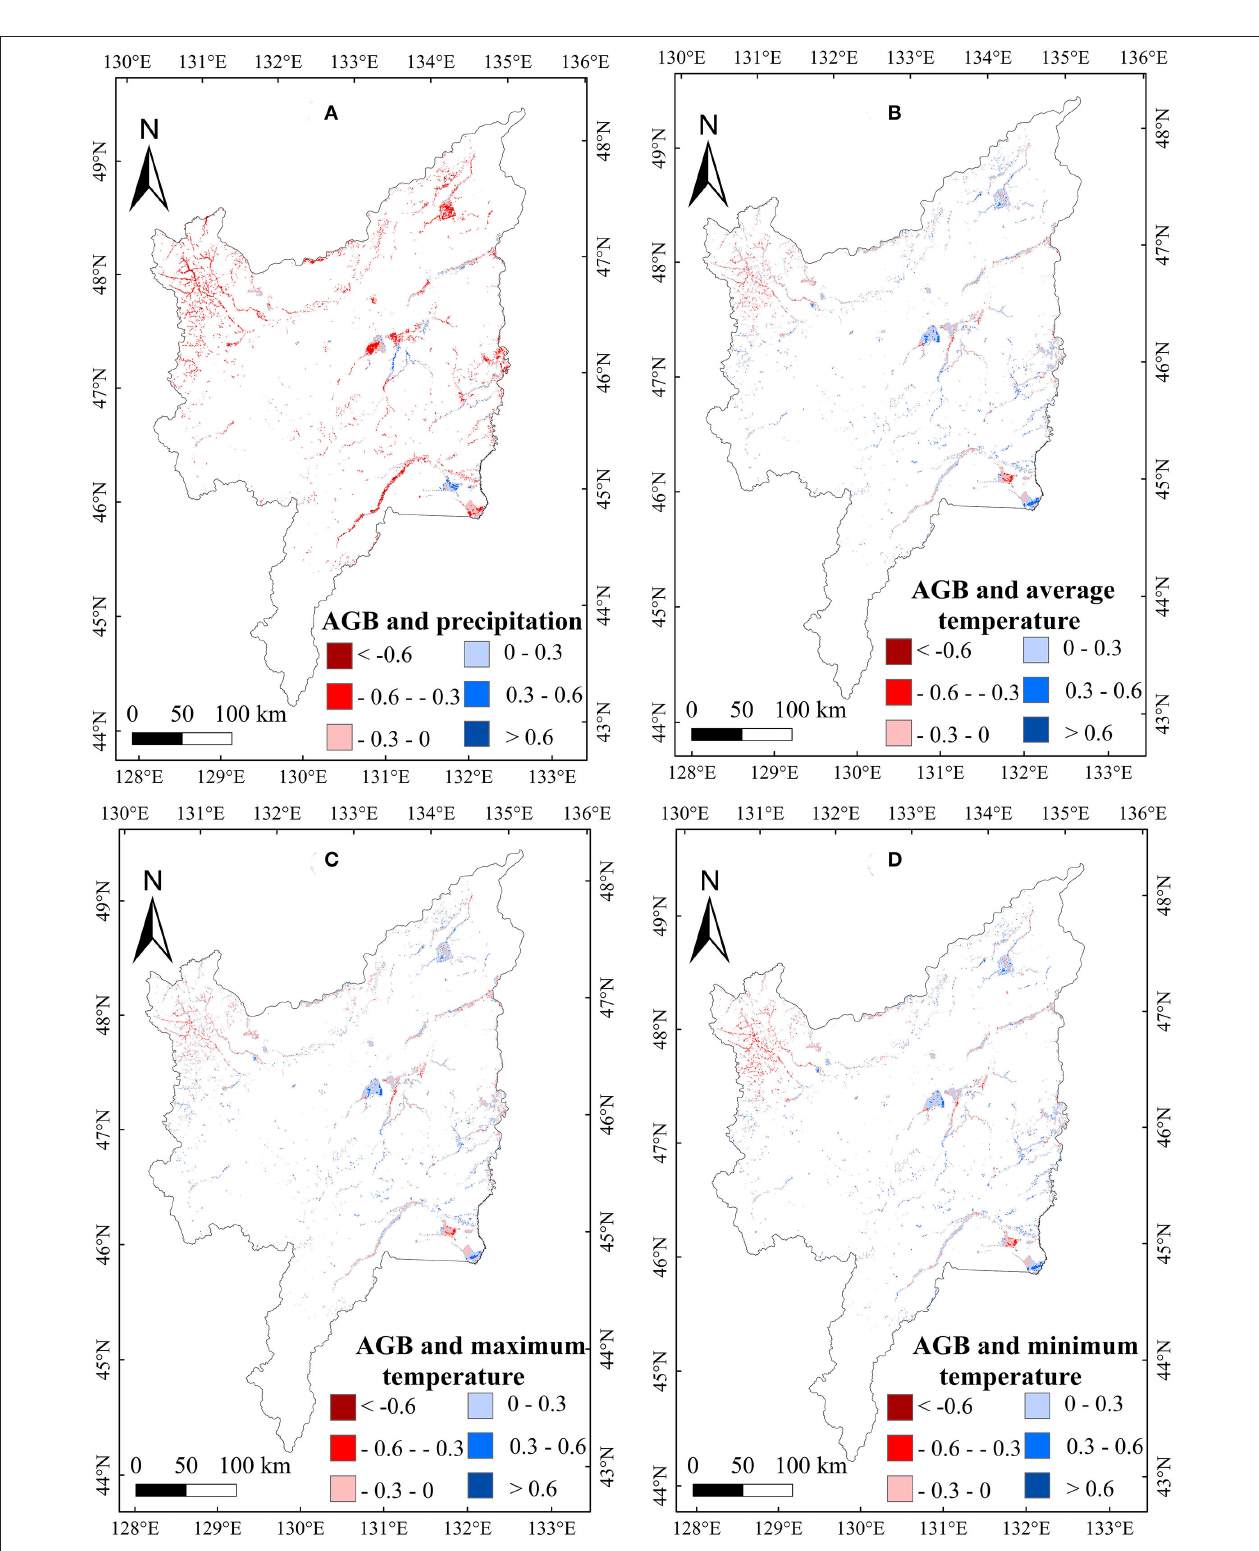
FIGURE 6 | Spatial patterns in relationships of AGB with precipitation (A) , T mean (B) , T max (C) , and T min (D) in January on the Sanjiang Plain marshes from 2000 to 2020.